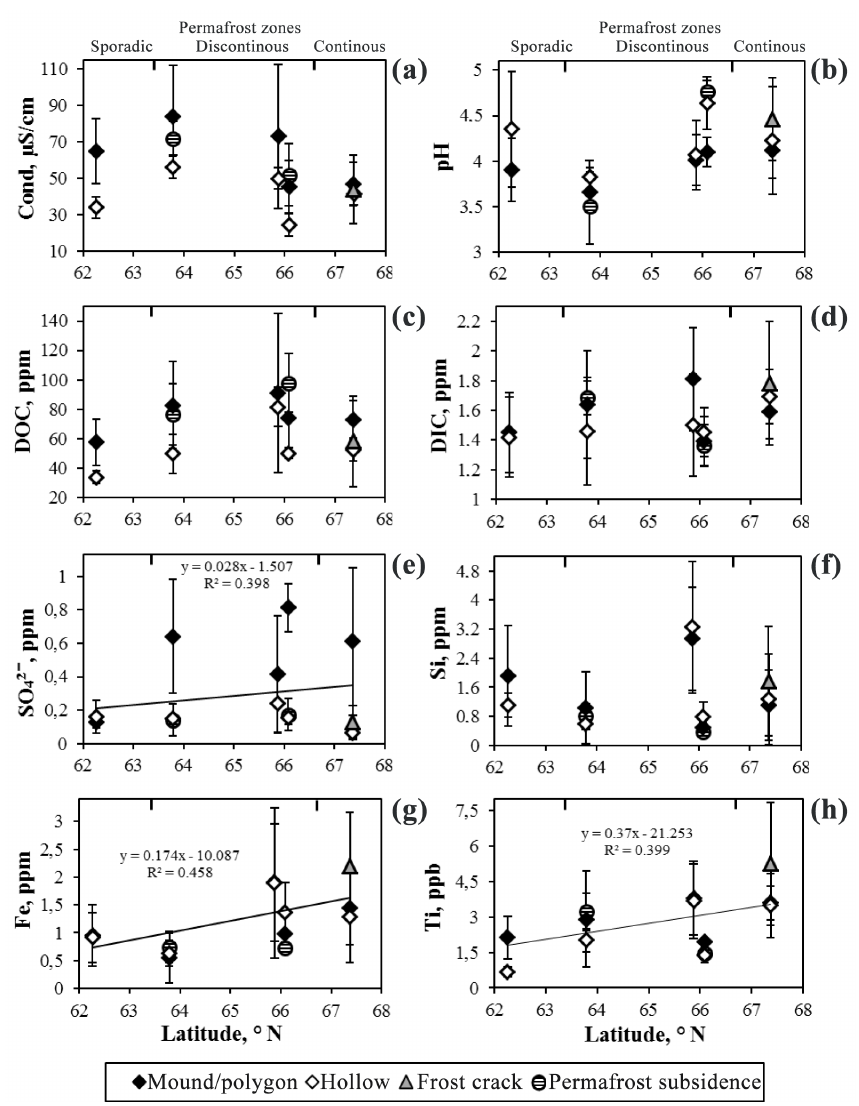
Figure 3. Mean values of specific conductivity (a) , pH (b) , DOC (c) , DIC (d) , SO 2 − porewaters of the WSL as a function of latitude for mound and polygons (solid diamonds), hollow (open diamonds), frost crack (grey triangles), and permafrost subsidence/depression (hatched circles). The solid line is a linear fit to all data with the regression equation given on each